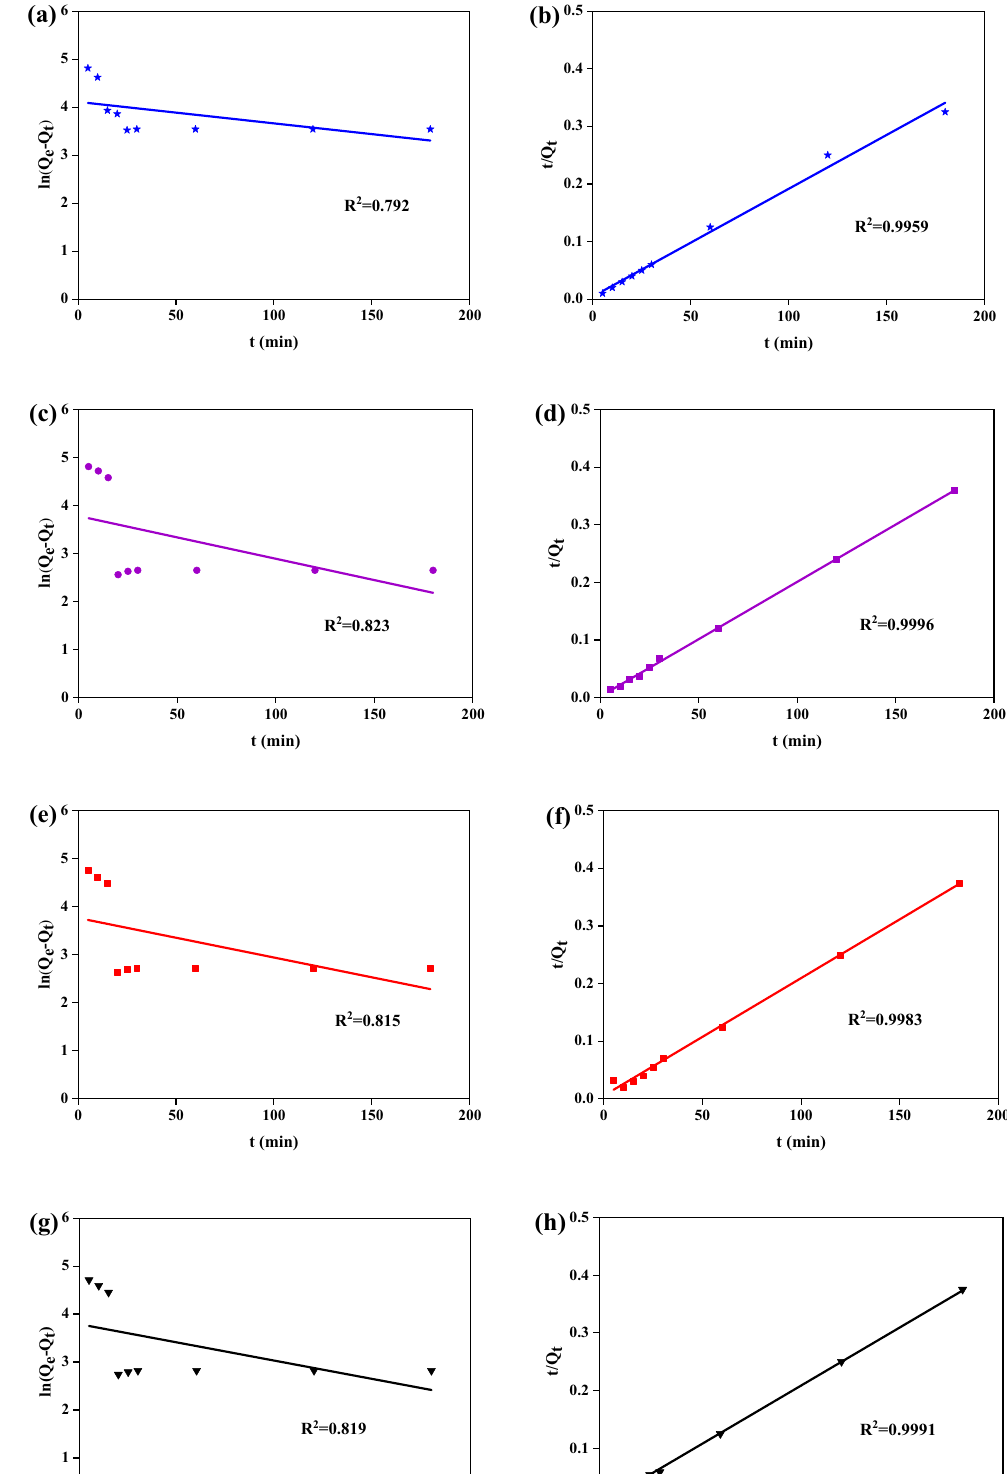
e and f CR was fitted by pseudo first and quasi two order kinetic models. g and h EB was fitted by pseudo first and quasi two